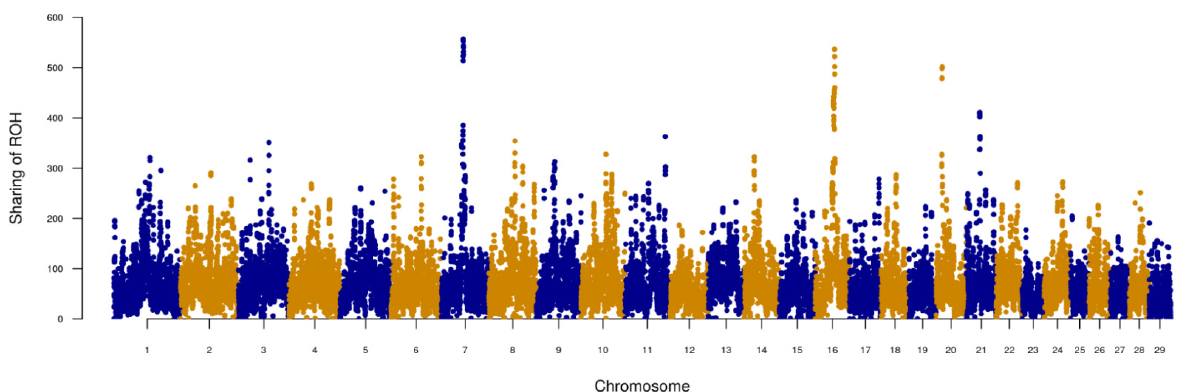
Figure 3. The ROH hotspot scores across all the sequenced individuals. The x axis shows the chromosome location on the 29 bovine autosomes. The y axis shows the number of animals with an ROH at this position (i.e., ROH hotspot scores). The total number of animals examined was 684. Each dot represents the count in windows of 100 kb.